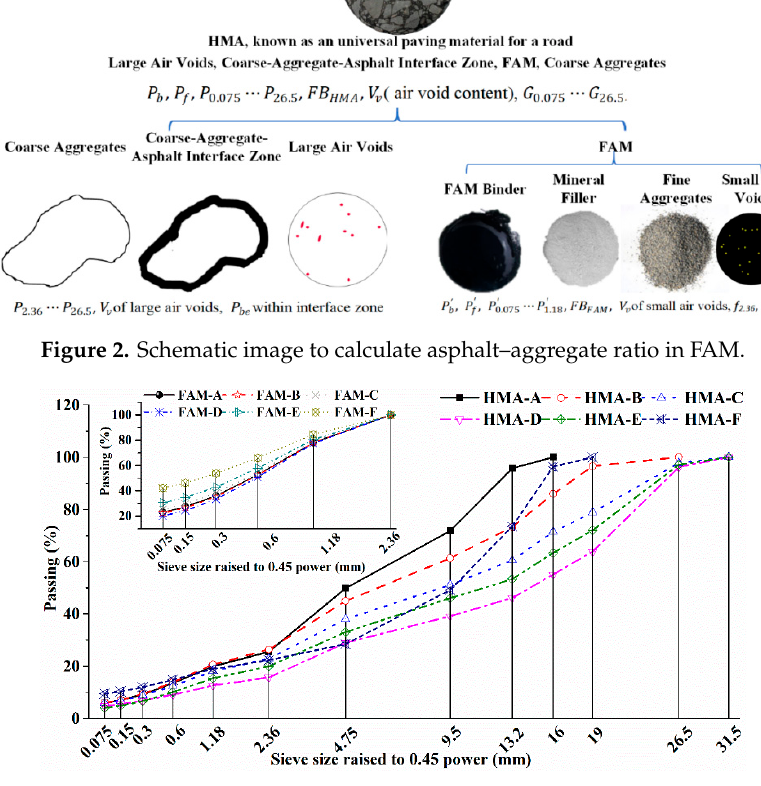
Figure 3. Gradation curves for six types of HMA and the corresponding FAM.